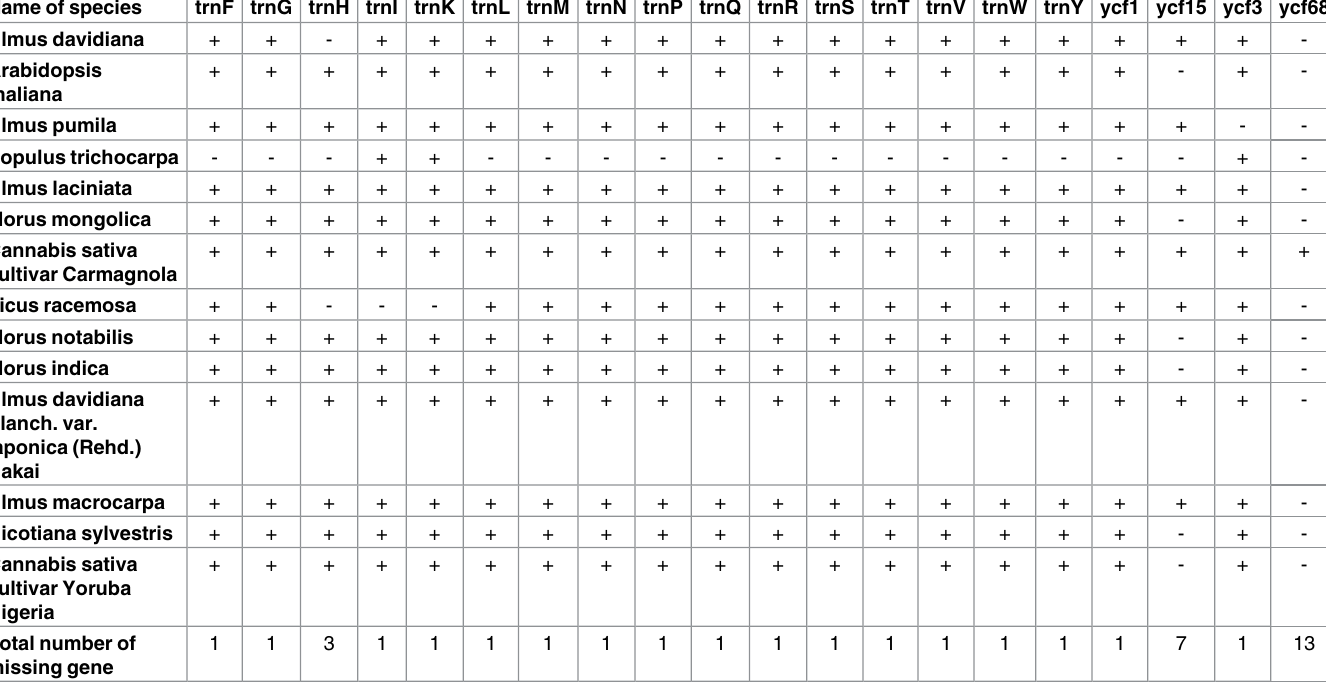
Table 4. Genes from the chloroplast genomes of various plant species. Name of